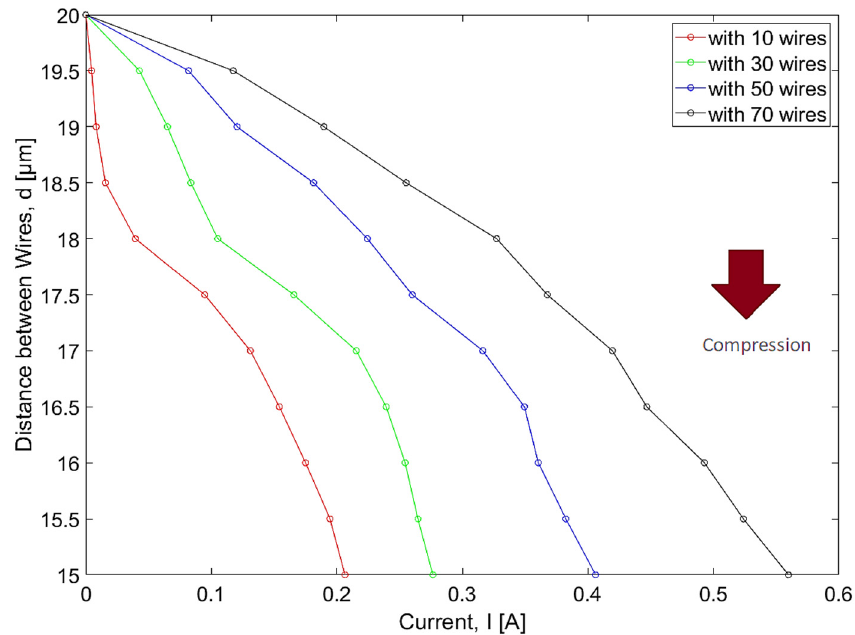
Figure 10. Reduction in the distance between wires as a function of applied current for 10, 30, 50 and 70 wires and a device assembled with HDPE.